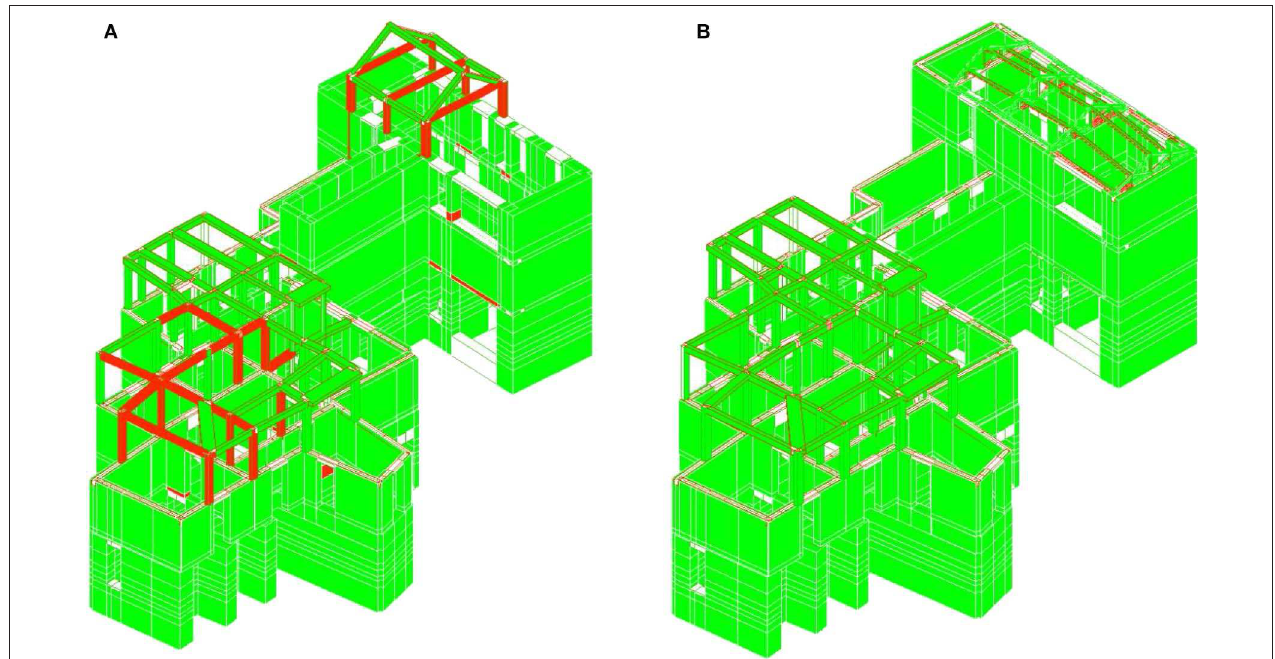
FIGURE 5 | Safety verifications after Pushover Analysis (A) before upgrading operations and (B) after upgrading operations.